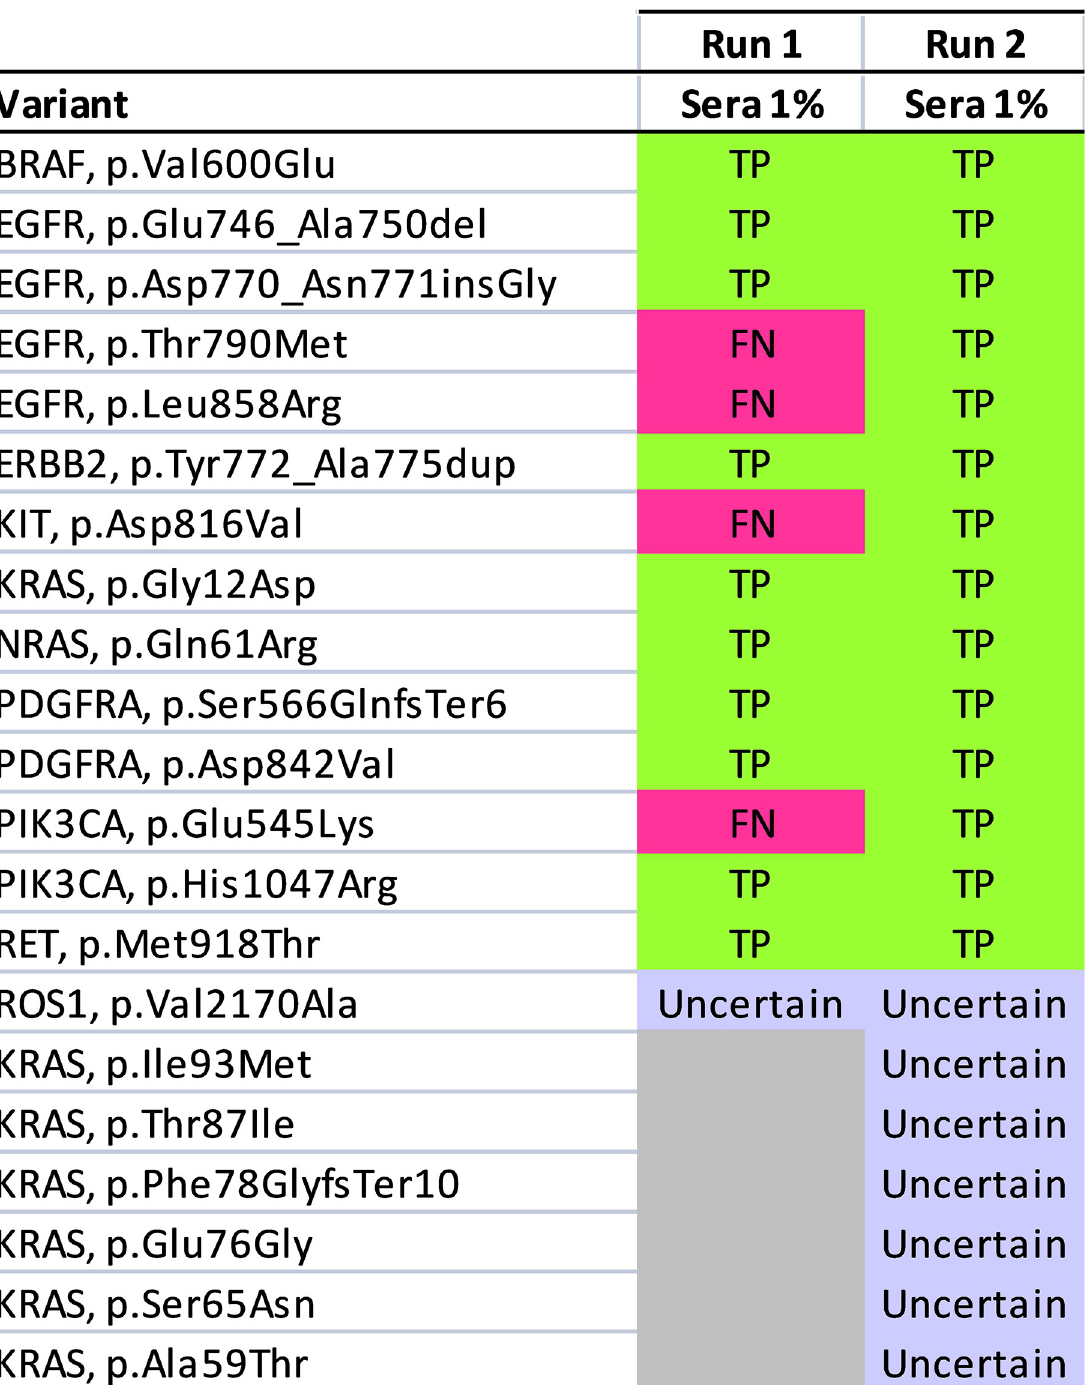
Fig 2. Analytical validation of the Seraseq 1 ctDNA Mutation Mix v2 reference standards. Variants with 1% allelic frequencies are listed vertically and samples are shown horizontally. True positive (TP), false negative (FN), and variants of uncertain significance are shown in green, red and purple respectively. Our results demonstrated that all the known variants were detectable when sequenced to at least ~1.7 million mapped reads.